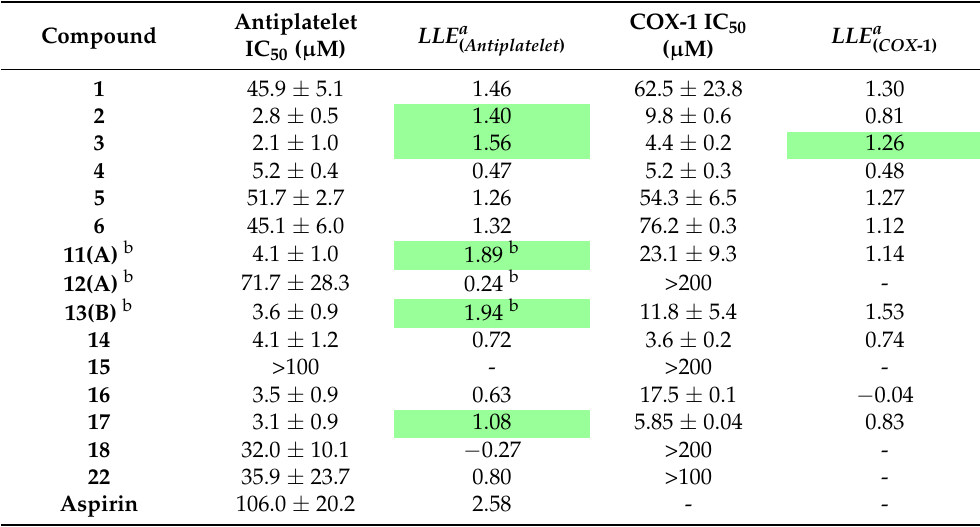
Table 2. Antiplatelet and Cyclooxygenase-1 (COX-1) inhibition assay results. For antiplatelet activity, washed human platelets were treated with gingerol derivatives for 3 min and then stimulated with arachidonic acid (100 µ M); data are presented as mean ± SEM, n = 3 for antiplatelet and n = 2 for COX-1 inhibition assay; aspirin was used as a positive control. Antiplatelet COX-1 IC 50 LLE a Compound ( Antiplatelet ) IC 50 ( µ M) ( µ